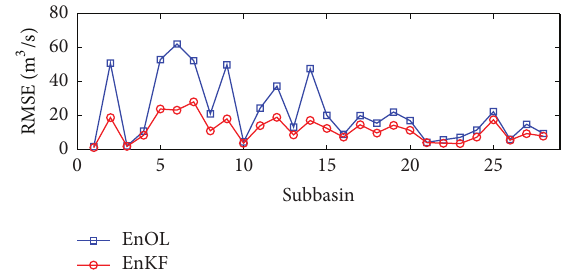
Figure 3: The RMSE (15) of the estimated streamflow by EnOL and EnKF at all subbasin outlets in the assimilation of the streamflow observations at the five interior sites.